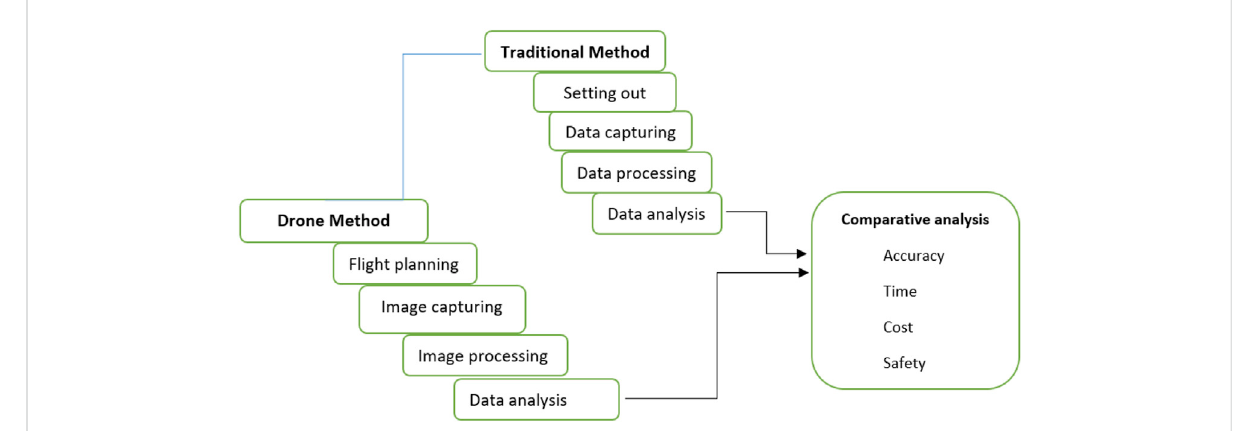
FIGURE 5 Drone vs. traditional approach framework.